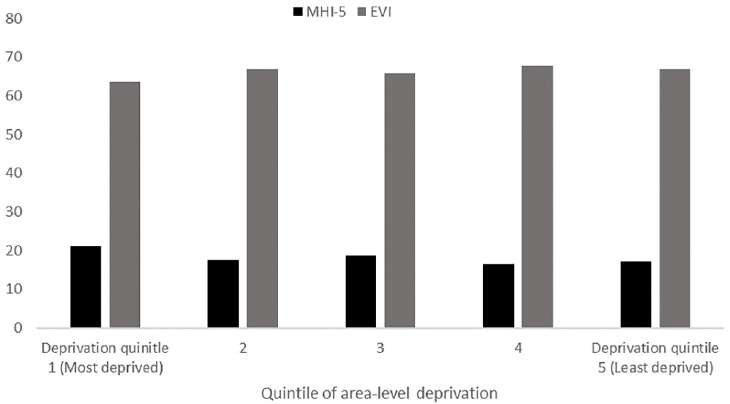
Fig 1. Average poor mental health score (MHI-5) and positive mental health score (EVI), by quintile of area-level deprivation.